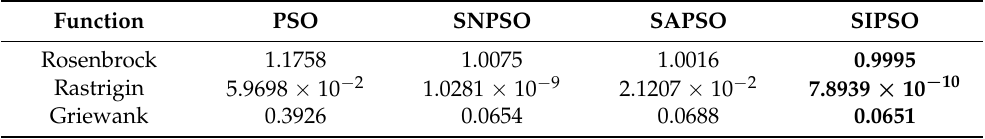
Figure 6. Comparison of convergence characteristics of four PSO-based algorithms. ( a ) Curve of Rosenbrock function; ( b ) curve of Rastrigin function; ( c ) curve of Griewank function. Table 4. Mean optimal function value of three criterion functions with different PSO-based